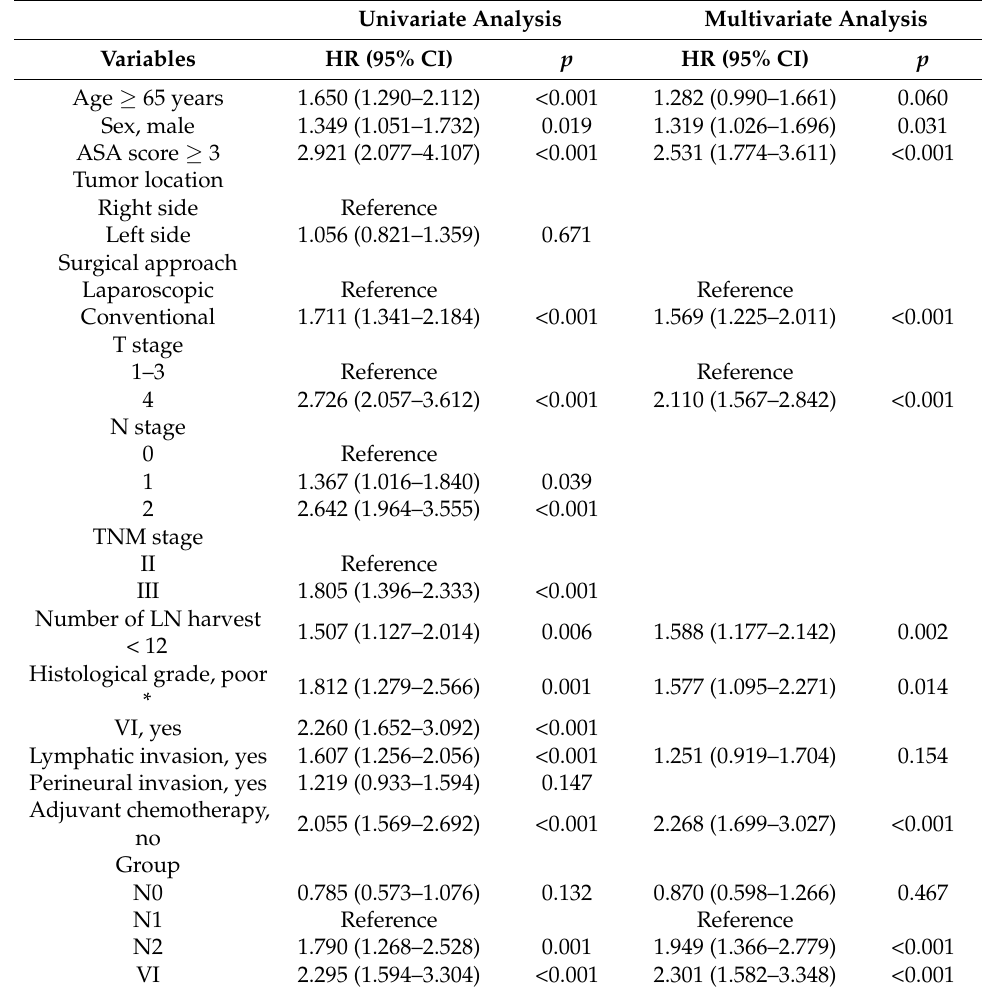
Table 4. Overall survival: the univariate and multivariate analyses.